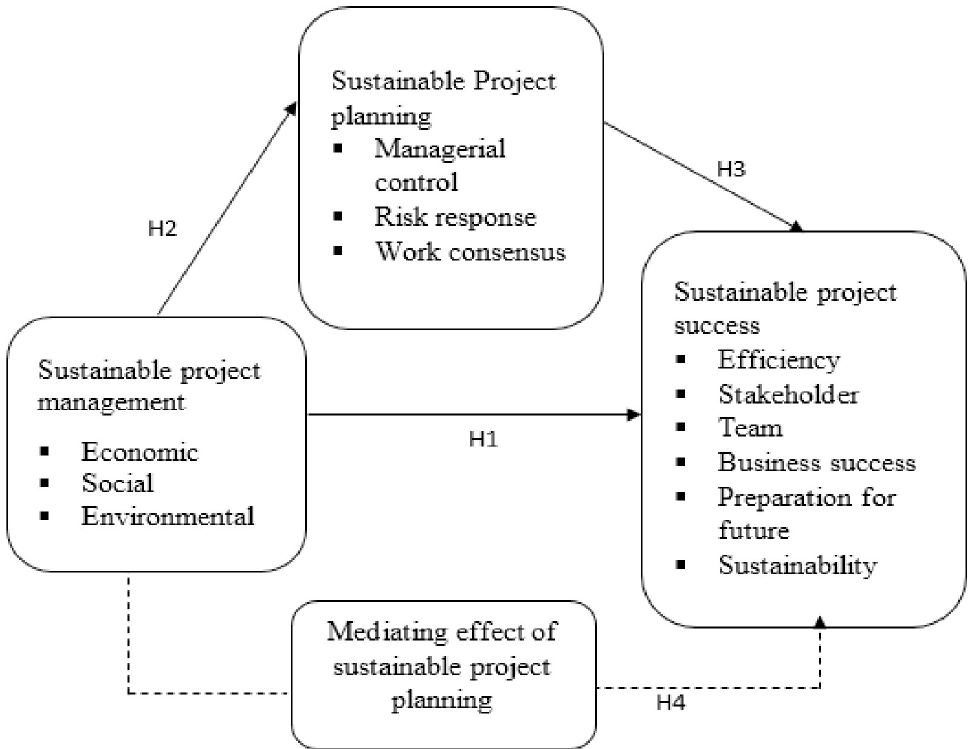
Fig 1. Conceptual